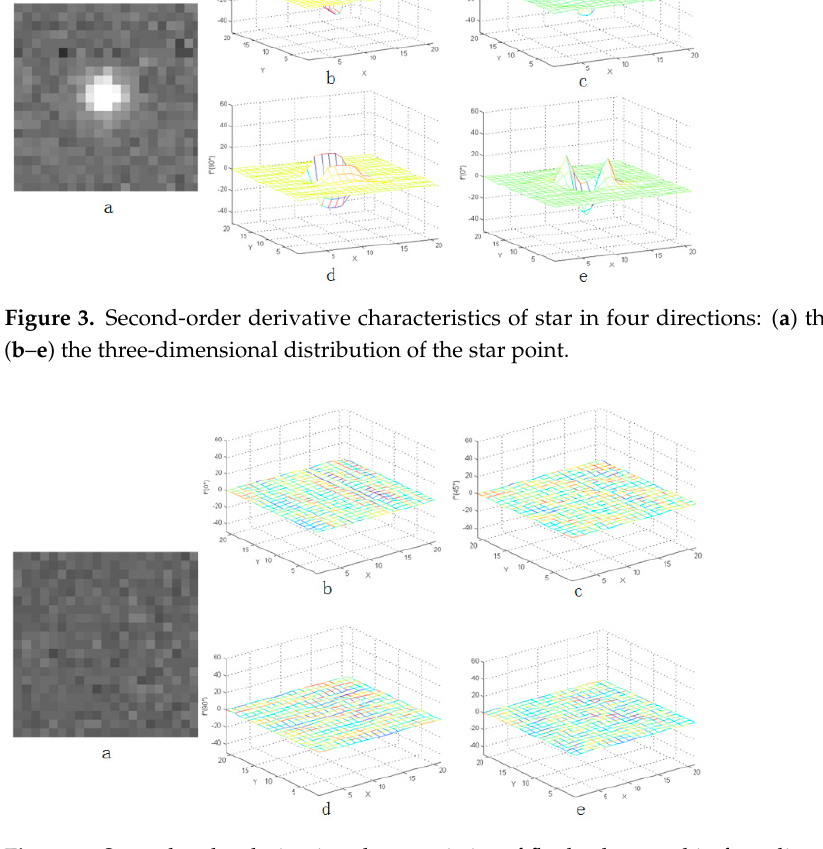
Figure 4. Second-order derivative characteristics of flat background in four directions: ( a ) the flat background and ( b – e ) the three-dimensional distribution of flat background.